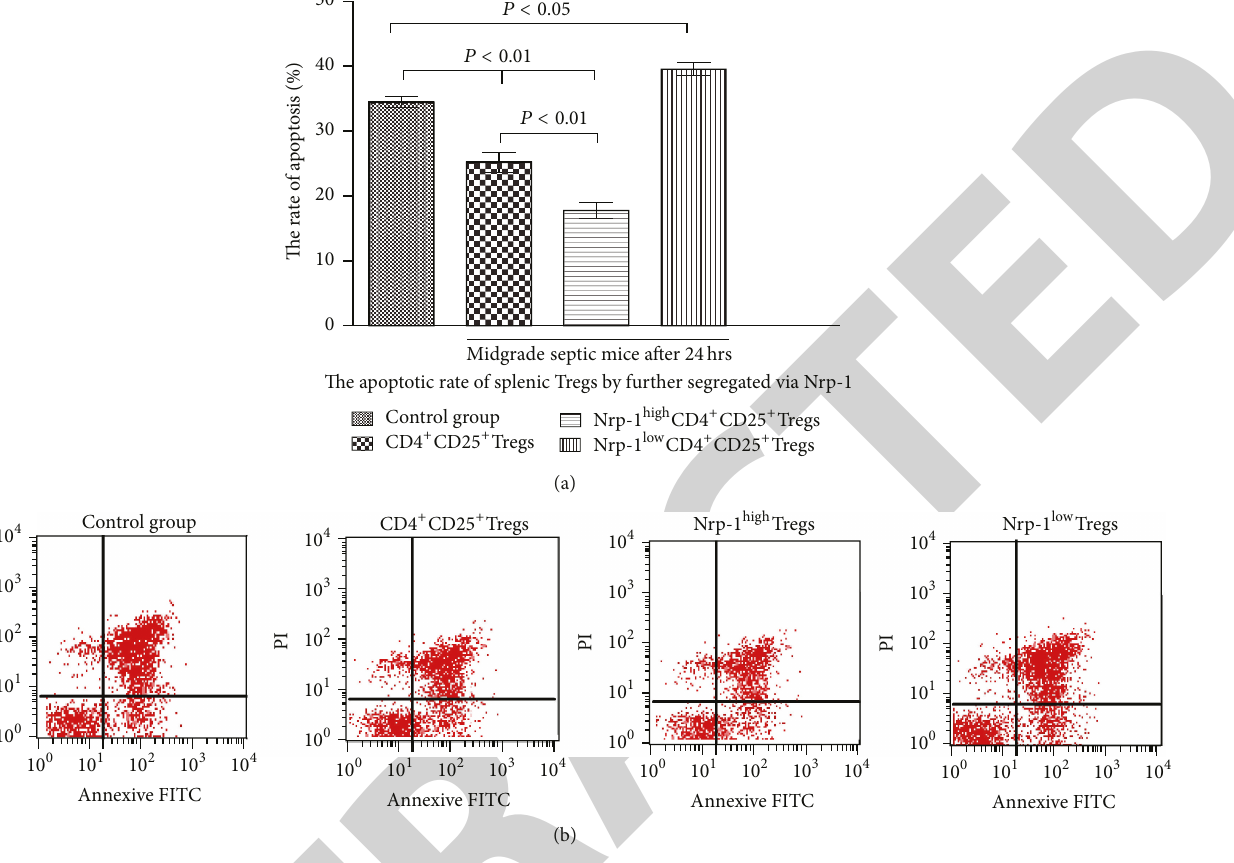
Figure 3: Nrp- 1 high CD 4 + CD 25 + Tregs showed the strongest resilience to apoptosis in sepsis. The apoptotic rate of Tregs was analyzed with annexin-V-FITC/PI flow cytometry at 24 hours after midgrade sepsis. Data was represented as mean ± standard deviation (SD) and analyzed by SPSS 17.0 software with a one-way ANOVA, 𝑛 = 4 per group ( 𝑃 < 0.05 or 𝑃 < 0.01 ).